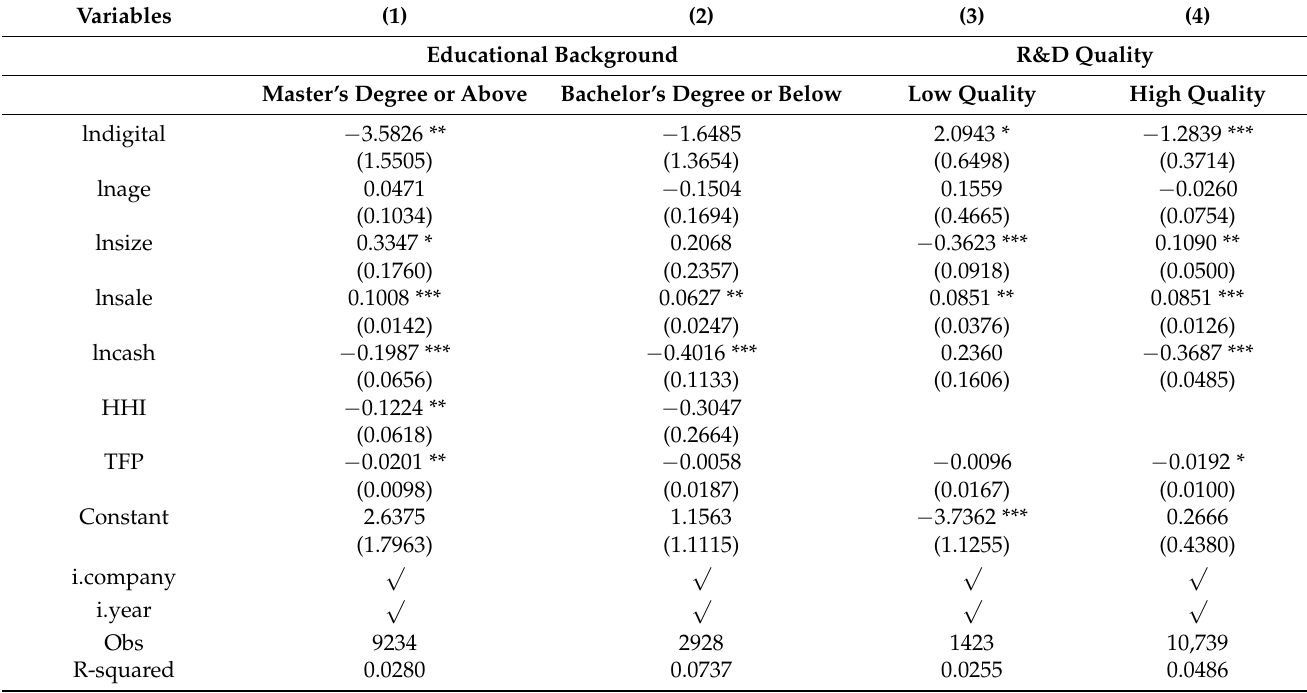
Table 8. Executive education background and R&D